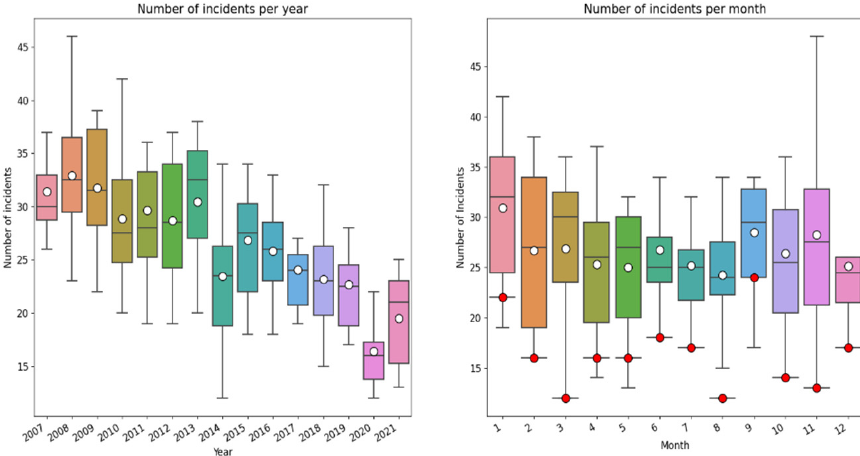
Figure 5. Year and month-wise box plot of reported incidents which were submitted within 183 days after the date of the incident from 2007–2021. The number of incidents is in both graphs the number of incidents per month. The white dots indicate the mean number of incidents. The red dots are the number of reported incidents in 2020.